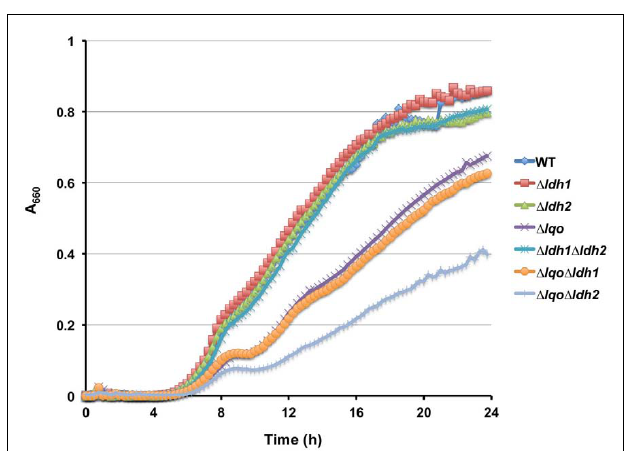
FIGUREA1 | Lqo, and to a lesser extent Ldh2, are required for maximal growth on L-lactate. Representative growth curve ofWT S. aureus strain COL and isogenic mutants grown in chemically defined medium supplemented with 1.0% L-lactate as a primary carbon source. Growth as determined by absorbance at 660nm was normalized to minimal growth in the absence of added